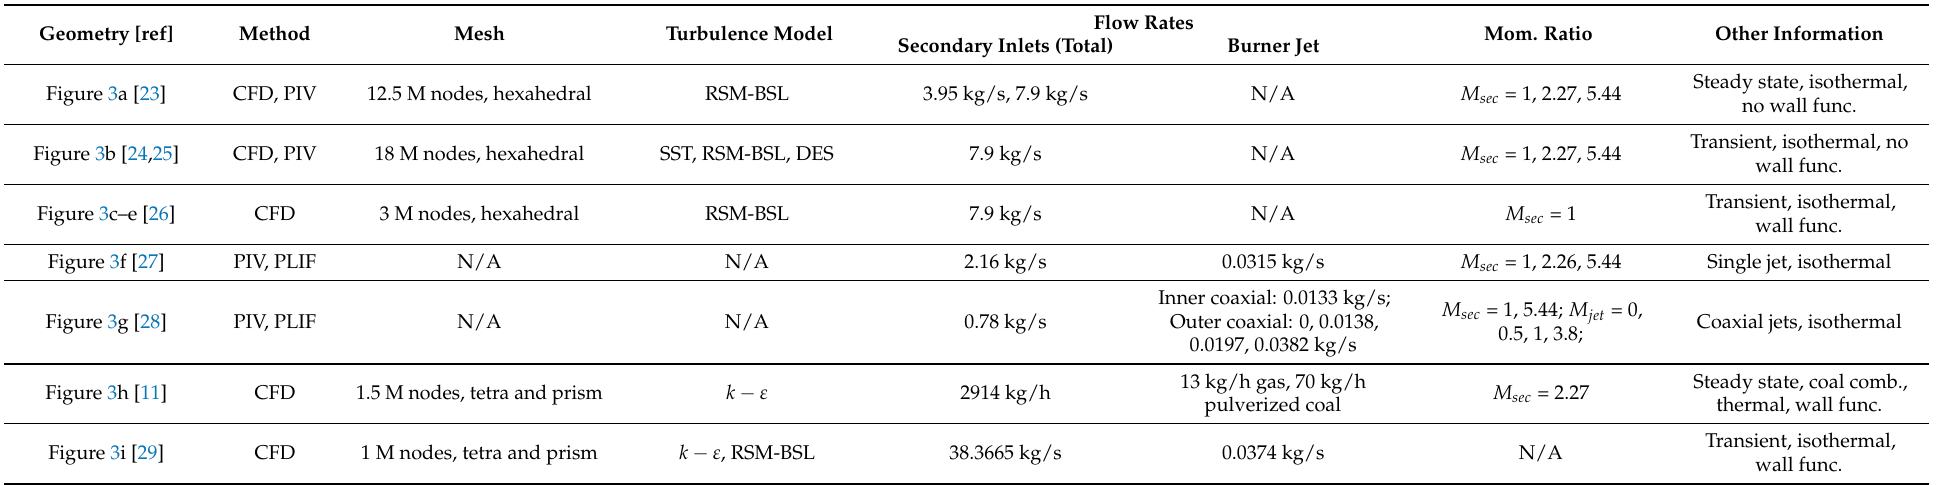
Table 1. Boundary